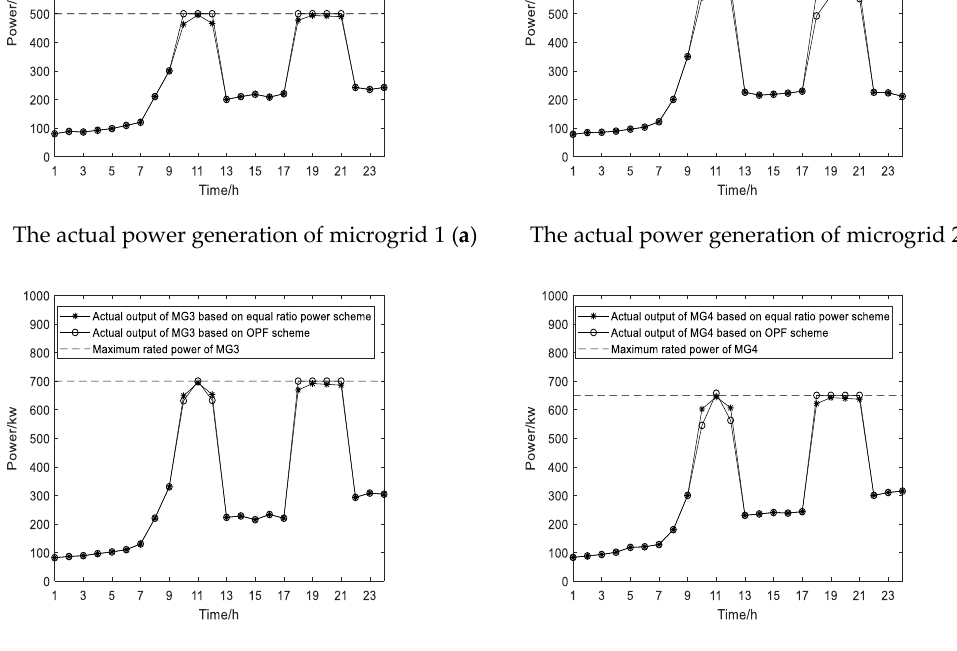
Figure 7. The actual power generation of each microgrid over 24 hours.